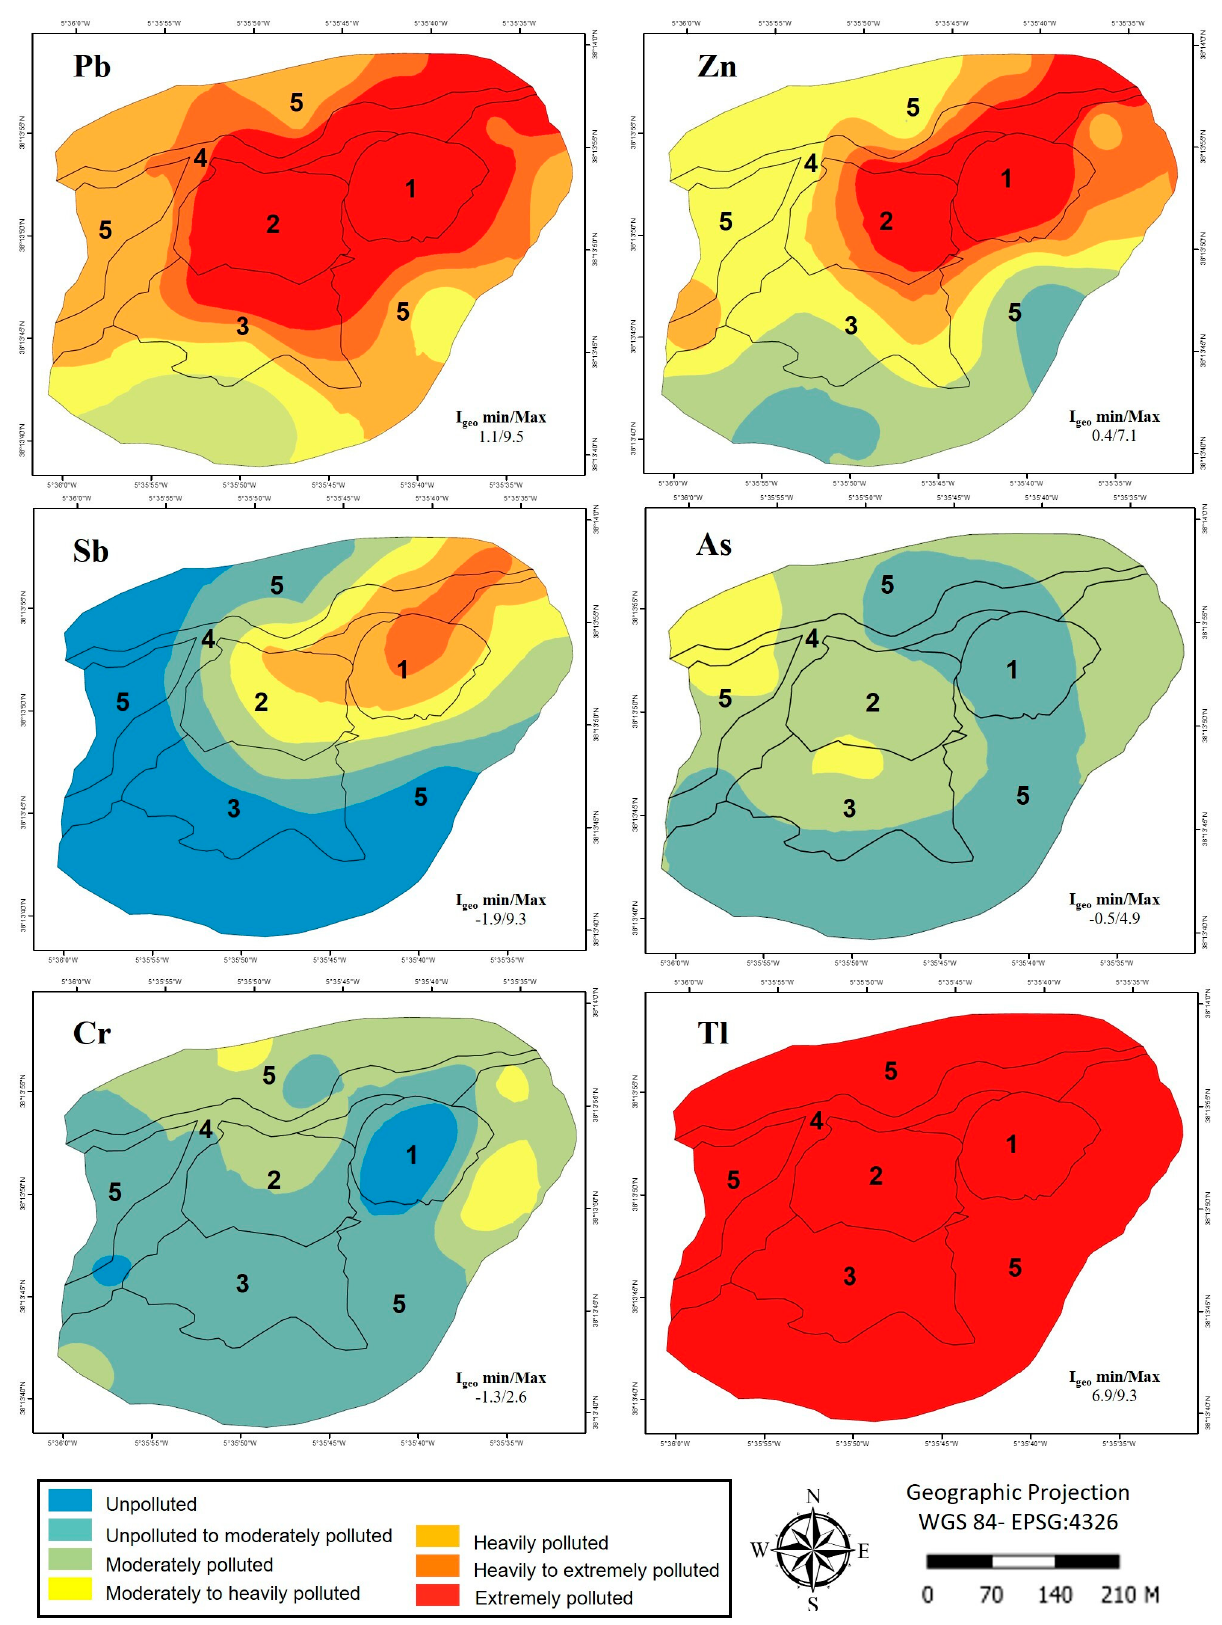
Figure 4. Pollution distribution according to the I geo in the study area: (1) mining sludge, (2) dump, (3) shrubland, (4) riparian zone, and (5) dehesa. Soil (n = 37).